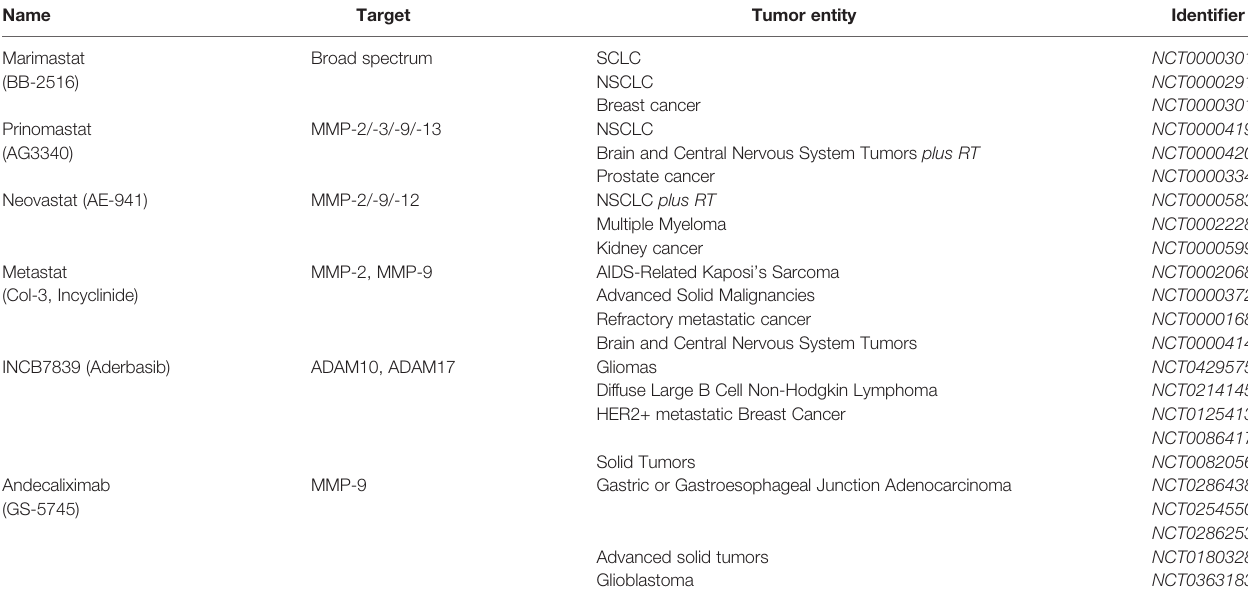
TABLE 1 | Summary of discussed metalloproteinase inhibitors in cancer-related clinical